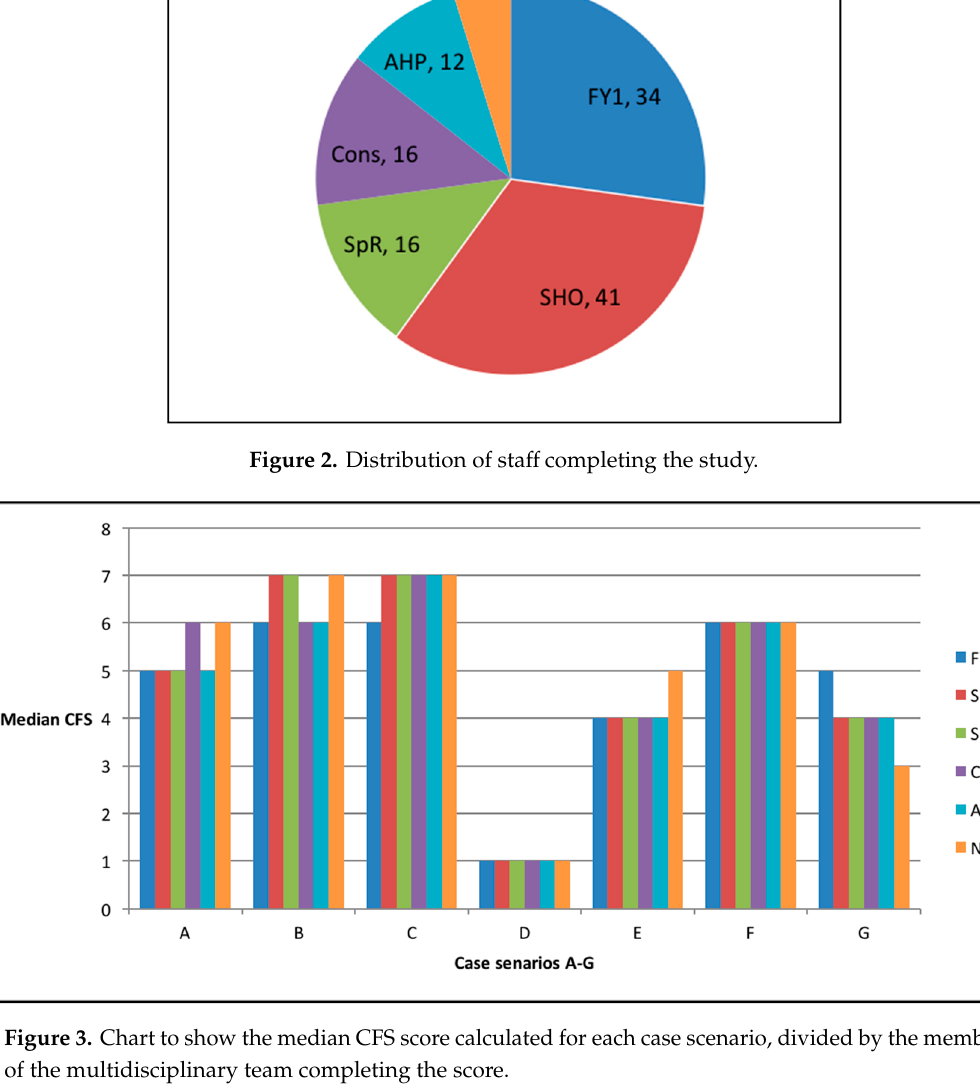
Figure 3. Chart to show the median CFS score calculated for each case scenario, divided by the member of the multidisciplinary team completing the